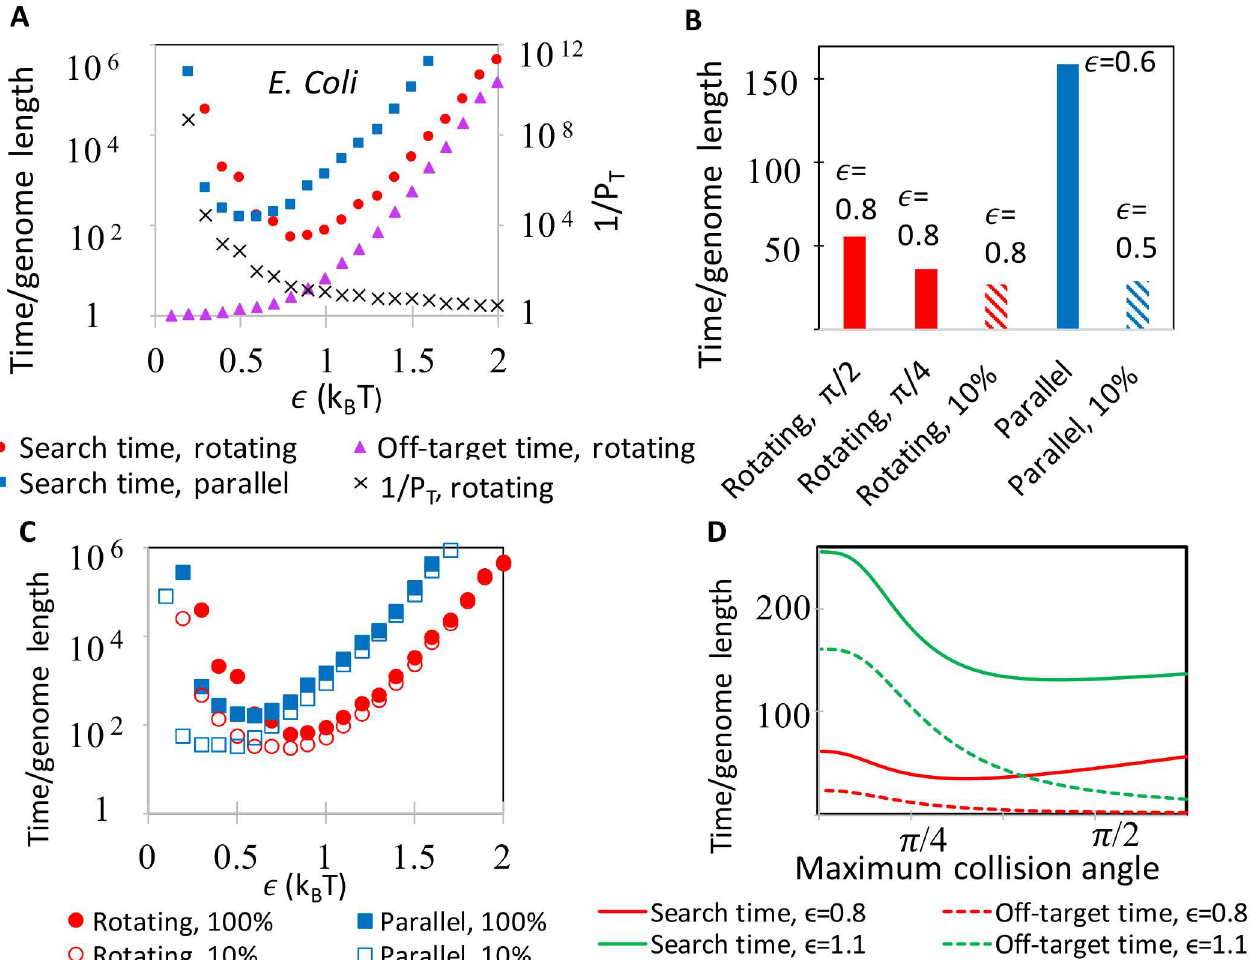
Fig 4. Determinants of total search time. (A) Kinetics of search as a function of (cid:15) , the attractive energy per matched site. Mean search time for a freely rotating searcher(red) and constrained parallelsearcherare comparedwith the averageinteractiontime with off-target sequenceper search cycle for freely-rotating searcher(purple). Also shown is the mean number of pairingattempts, 1/ P T . Here τ diff = 0, θ max = π /2, and genome statistics taken from the E. coli genome.All times in this figure are measuredin units in which the rate of unbinding equals 1. (B) Minimum attainablehomology search times. Indicatedare the θ max ( π /2 when not indicated),the requiredspecificity (100% if not indicated), and the value of (cid:15) at which these minima occur. (C) Comparisonbetweenthe search time with T D set to guaranteeperfect specificity( σ = 1, as in panel B), and when it is set such that σ = 0.1 (empty symbols). (D) Homology search time (solid lines) and averageoff-target interaction time (dashedlines) for a freely rotating searcheras a function of θ max .